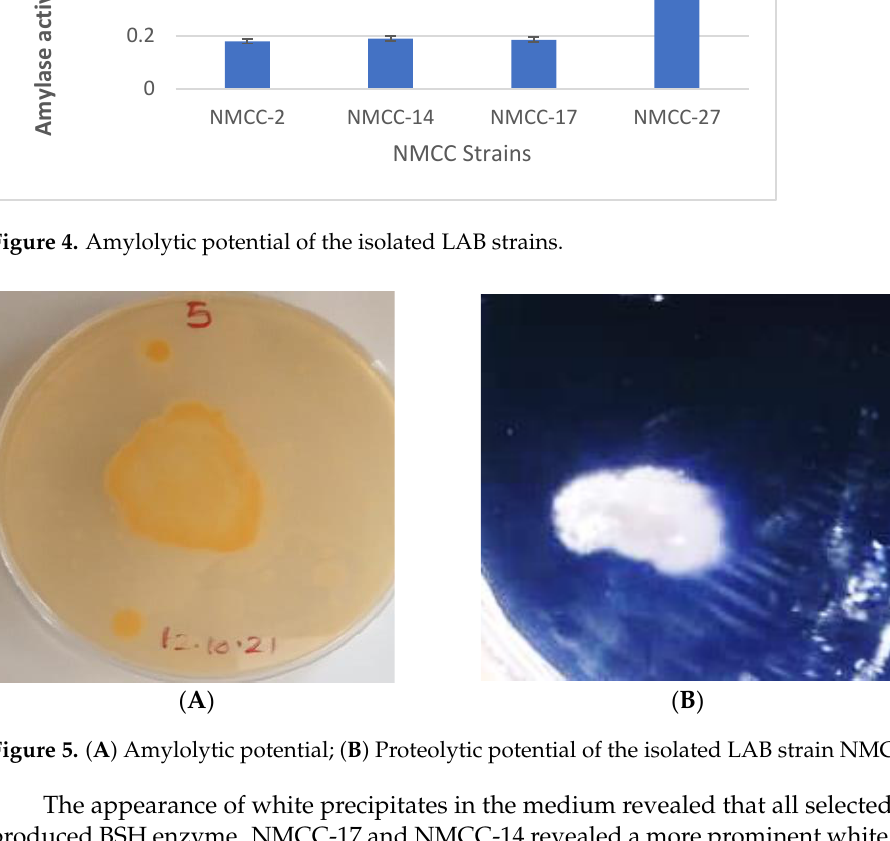
( B ) Figure 6. Safety profile: ( A ) DNAs; ( B ) Hemolytic activity. The test plates inoculated with all the isolates studied revealed white zones. Table 3. Hemolytic and bile salt hydrolyzing (BSH) potential of the isolated LAB strains. NMCC Strain